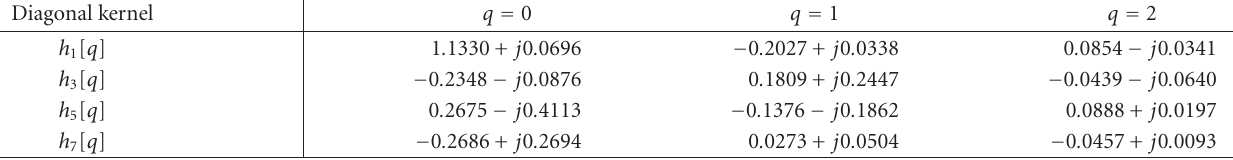
Table 2: Memory polynomial PA coe ffi cients extracted for a real PA with maximum nonlinearity order 2 K +1 = 7 and maximum lag Q = 2. Diagonal